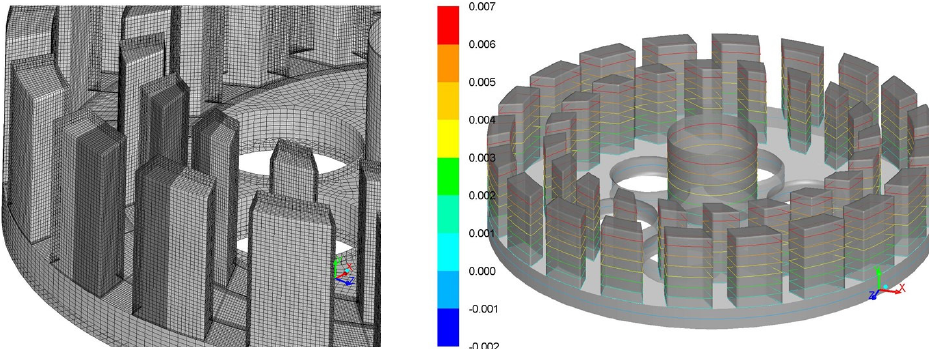
Figure 3. Rotor grid with local refinement ( left ) and visualization planes ( right